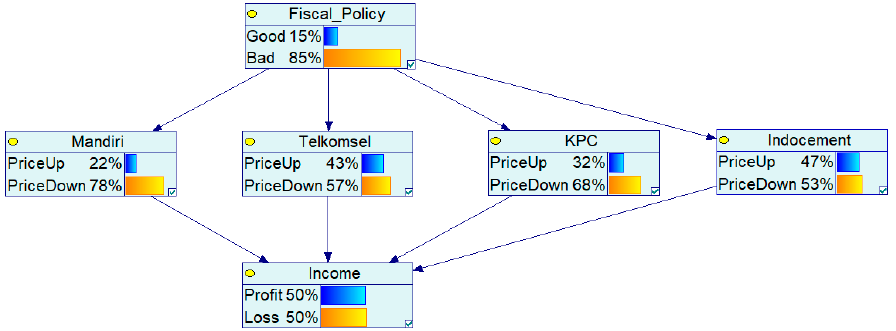
Figure 12 . Investment #2 – The calculation of probability values using the ByNowLife reasoning